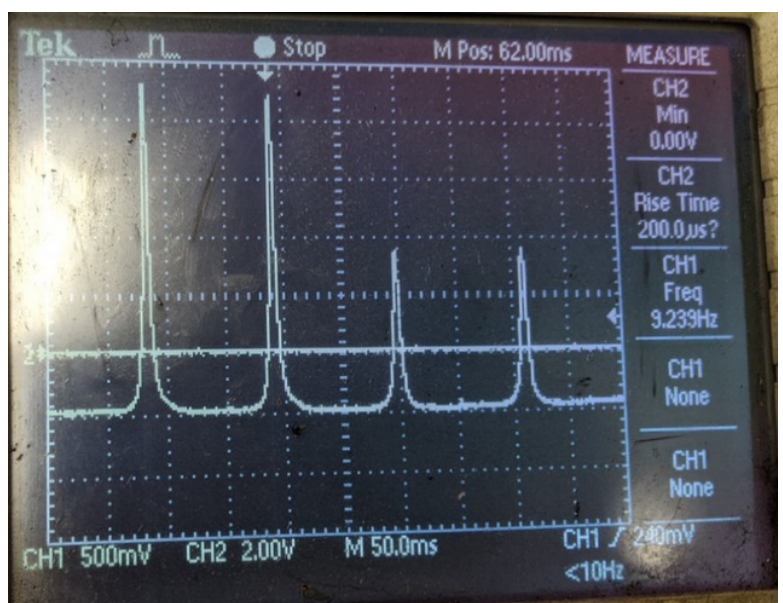
Figure A2. Detail of the cylinder head modification. Note that the seal gland area is completely free from carbon deposits.